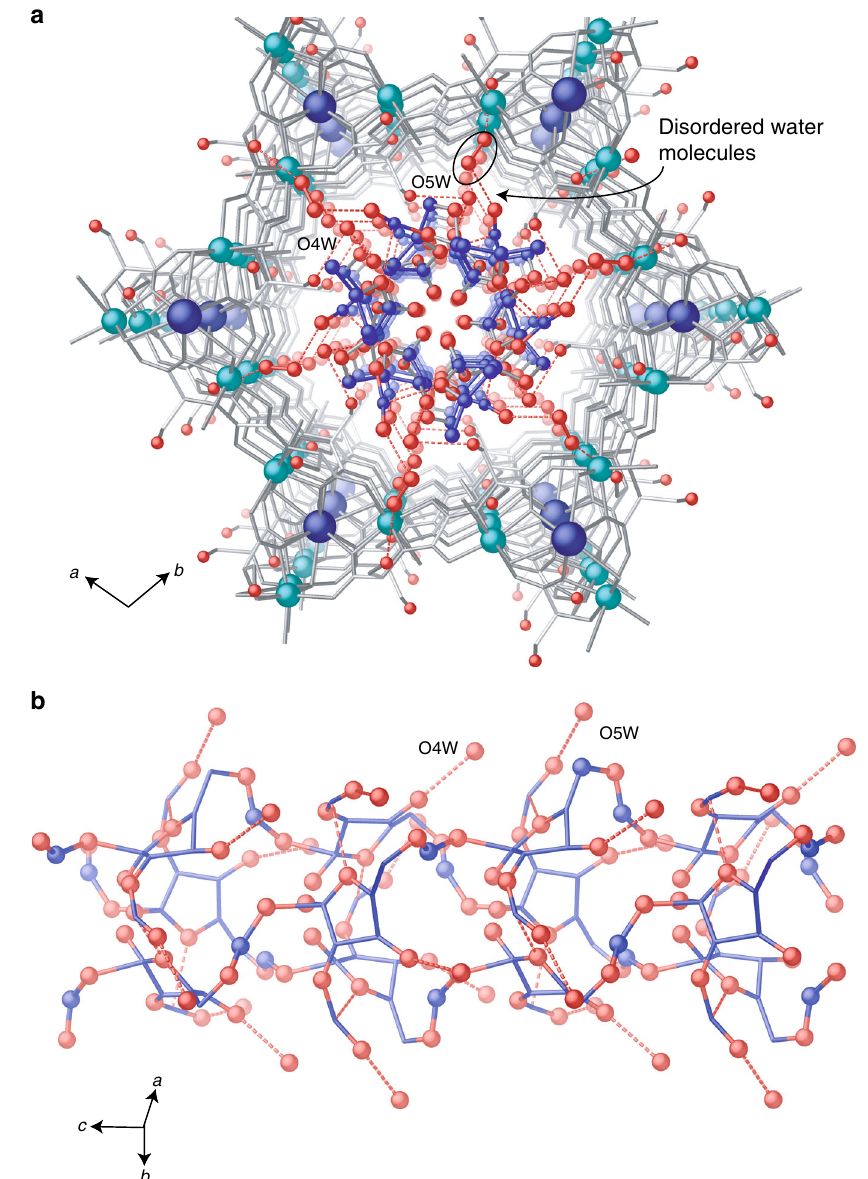
Fig. 2 Crystal structure of 1a@2. a Perspective view along c crystallographic axis of a single channel underlining pores fi lled by guest molecules depicted as blue sticks with the only exception of oxygen atoms, depicted as red spheres. The H-bond interactions are depicted as red dashed lines. Disordered positions of lattice water molecules having a key role in host – guest interactions are highlighted (see details of re fi nement in Supplementary Methods). b Supramolecular chains of 1a molecules packed in pores of 2 propagating along the direction of channels (all possible orientations are included). Carbon are represented by blue sticks whereas oxygen atoms of guest molecules and water molecules mediating host – guest interactions are represented by red